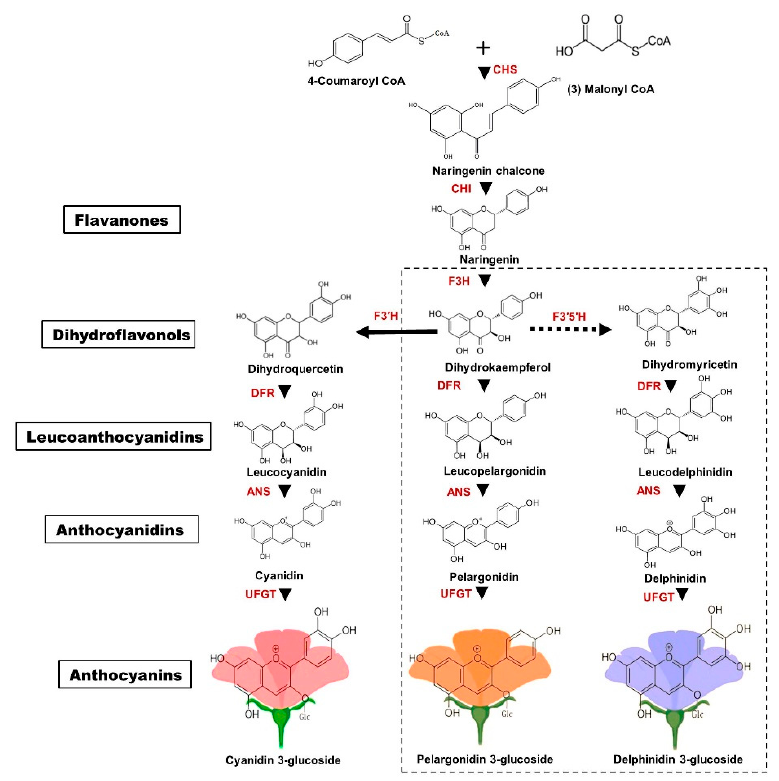
Figure 1. Schematic representation of the anthocyanin biosynthesis pathway. Enzymes involved in the biosynthesis pathway are shown in red. CHS—chalcone synthase; CHI—chalcone isomerase; F3H—flavanone 3-hydroxylase; F3 ′ H—flavonoid 3 ′ -hydroxylase; F3 ′ 5 ′ H—flavonoid 3 ′ 5 ′ - hydroxylase; DFR—dihydroflavonol 4-reductase; ANS—anthocyanidin synthase; UFGT— UDP-glycosyl transferase. Chrysanthemum flowers only accumulate cyanidin-based anthocyanins;